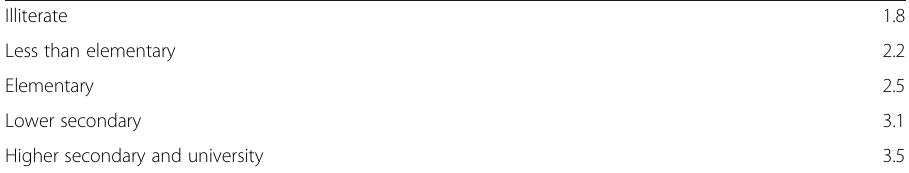
Table 11 Number of birth control methods known, among 8 indicated, according to wife ’ s education, three big cities in Italy, 1972 Illiterate 1.8 Less than elementary 2.2 Elementary 2.5 Lower secondary 3.1 Higher secondary and university